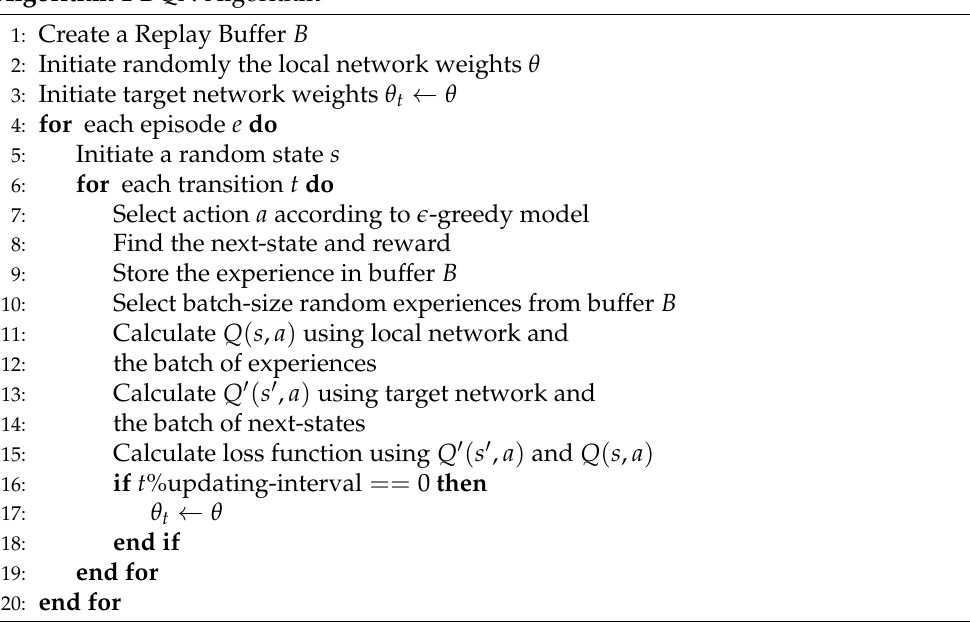
Algorithm 1 DQN